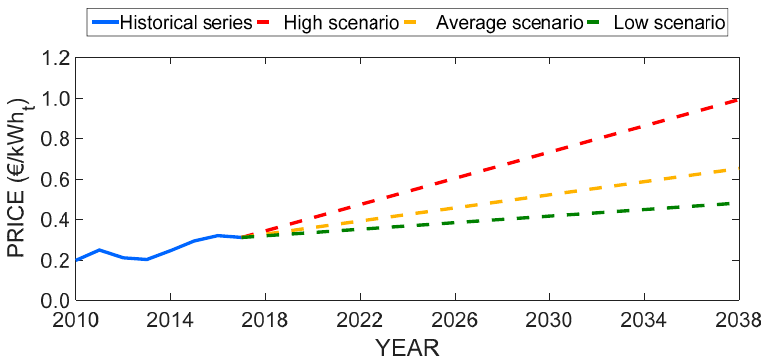
Figure 5. Natural gas price evolution and estimation from 2010 to 2038, Group I6.